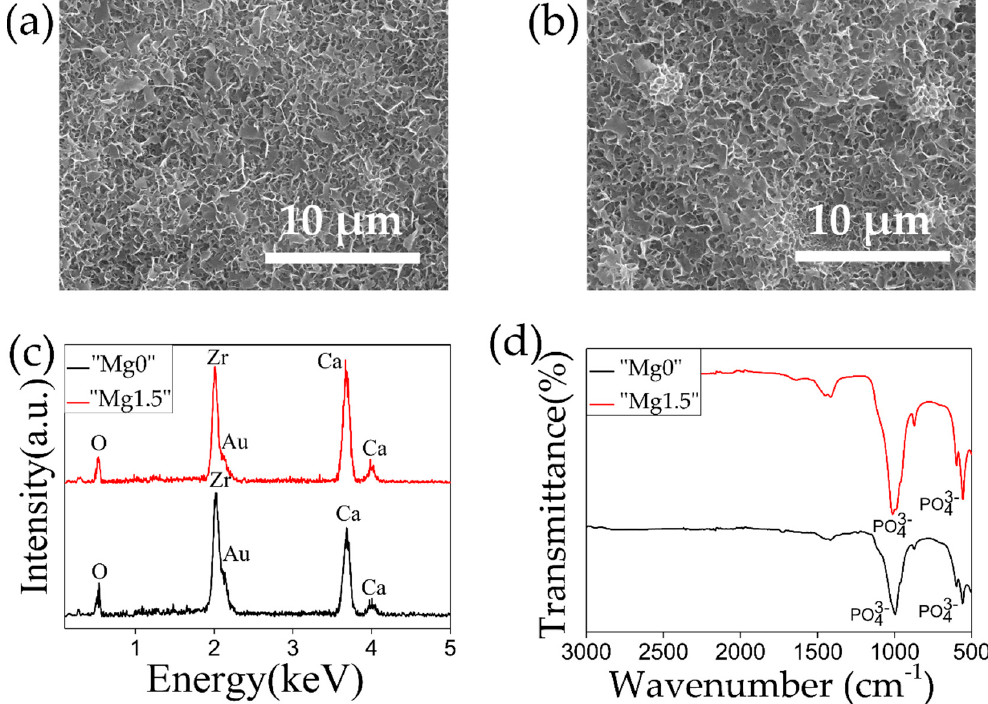
Figure 6. SEM images of ( a ) “Mg0” solution and ( b ) “Mg1.5” solution-treated 3Y-TZP samples after 7 days SBF immersion. ( c ) EDX and ( d ) FTIR plots comparing properties of “Mg0” solution and “Mg1.5” solution-treated 3Y-TZP samples after 7 days SBF immersion.